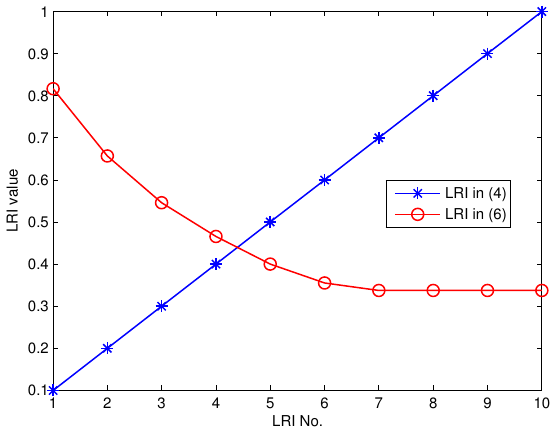
Figure 8. LRI with and without optimal scheduling in Scenario 2.